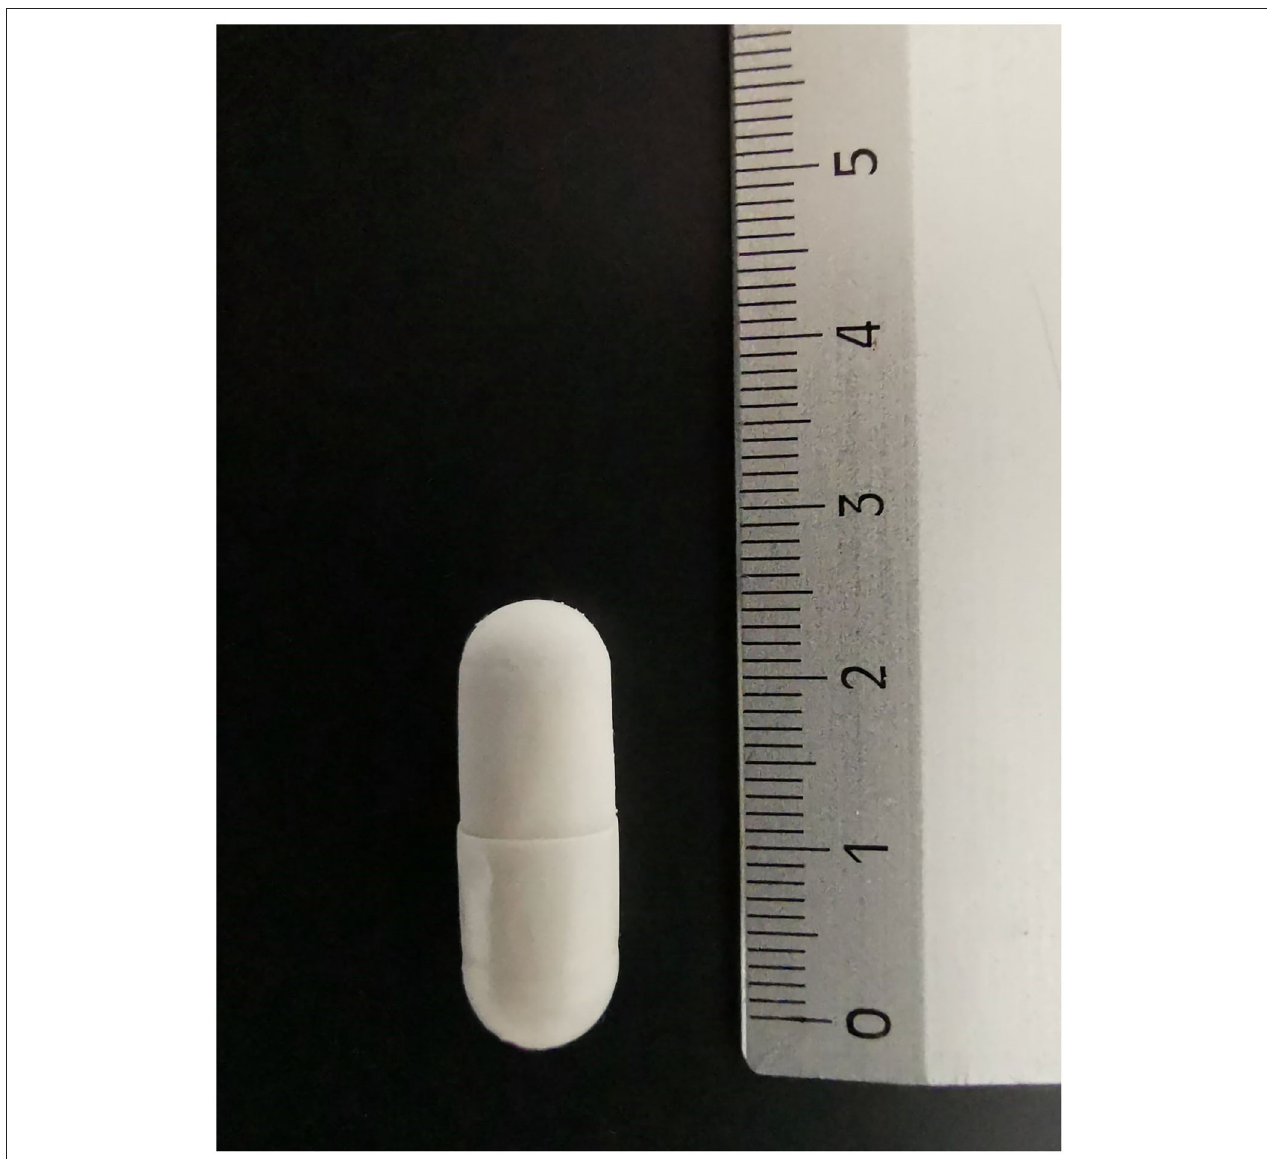
FIGURE 1 | Example of capsule containing the fecal material (the reference in the ruler is in centimeters).